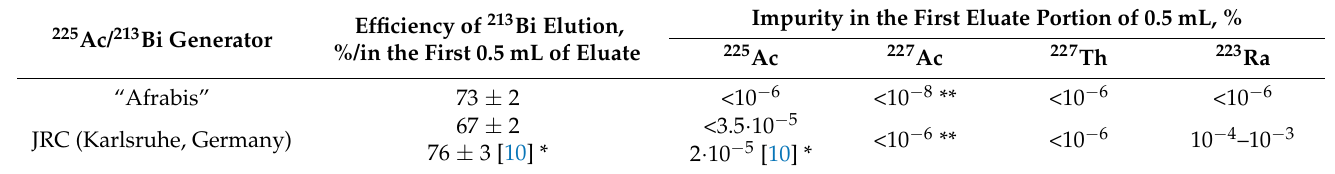
Table 2. Results of 213 Bi elution from the single-column 225 Ac/ 213 Bi generator with AG MP-50 resin. Impurity in the First Eluate Portion of 0.5 mL, % 213 Bi Elution, 225 Ac/ 213 Bi Generator Efficiency of 225 Ac 227 Ac 227 Th 223 Ra %/in the First 0.5 mL of Eluate “Afrabis” JRC (Karlsruhe,